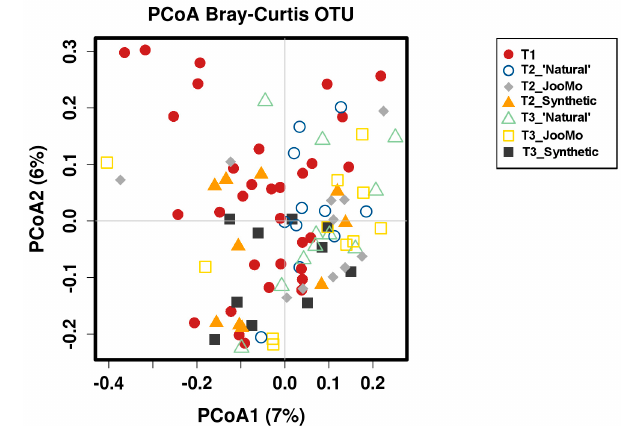
Figure 11. PCoA plot of the different time points per group. Each point refers to one microbiome measurement. Shapes and colors indicate the different time points and the product group (see legend). No significant grouping.